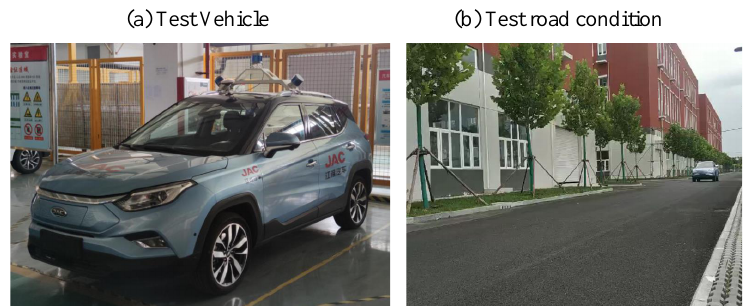
Figure 16. Vehicle test.